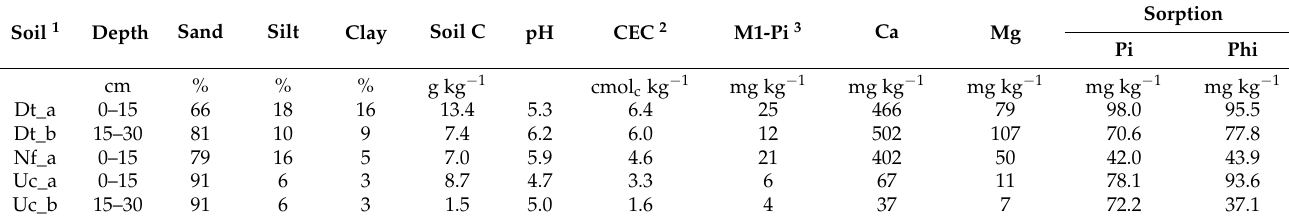
Table 1. Select properties of experimental